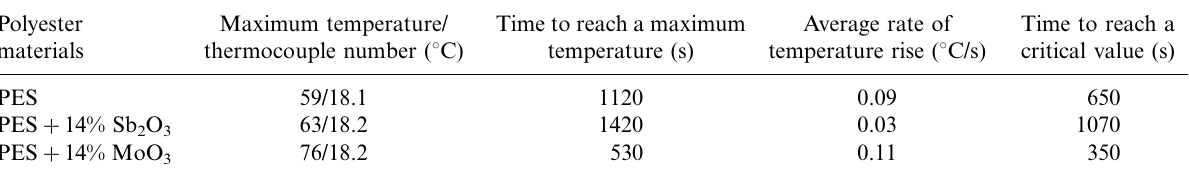
Table 2. Basic parameters characterising temperature distribution during the combustion of modified and unmodified